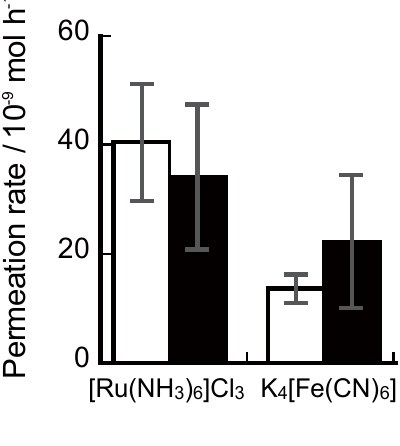
Figure 7. Permeability of [Ru(NH column) and (PAH-PSS) values of three measurements are